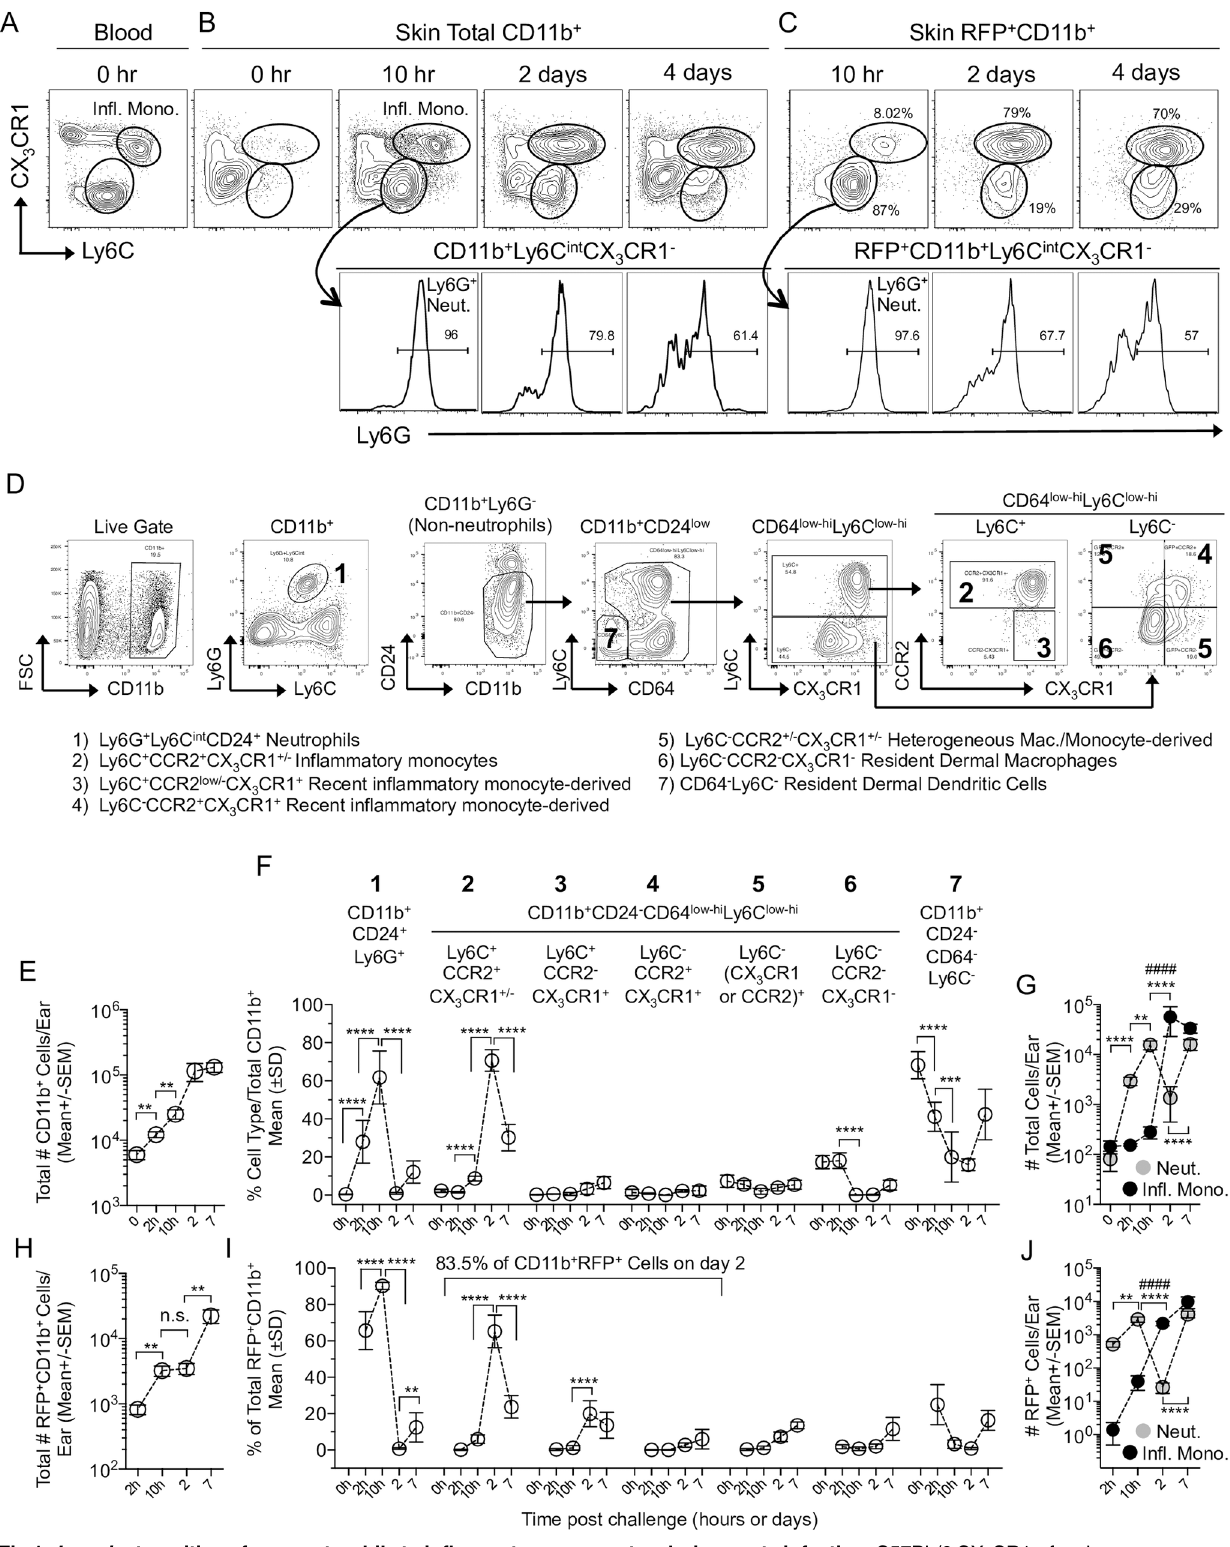
Fig 1. L . major transitions from neutrophils to inflammatory monocytes during acute infection. C57BL/6CX 3 CR1-gfp mice were injectedwith 2x10 5 L . major -RFPparasites i.d. in the ear. (A-D) Representative plots of blood or skin cells stainedwith the indicatedmarkers.